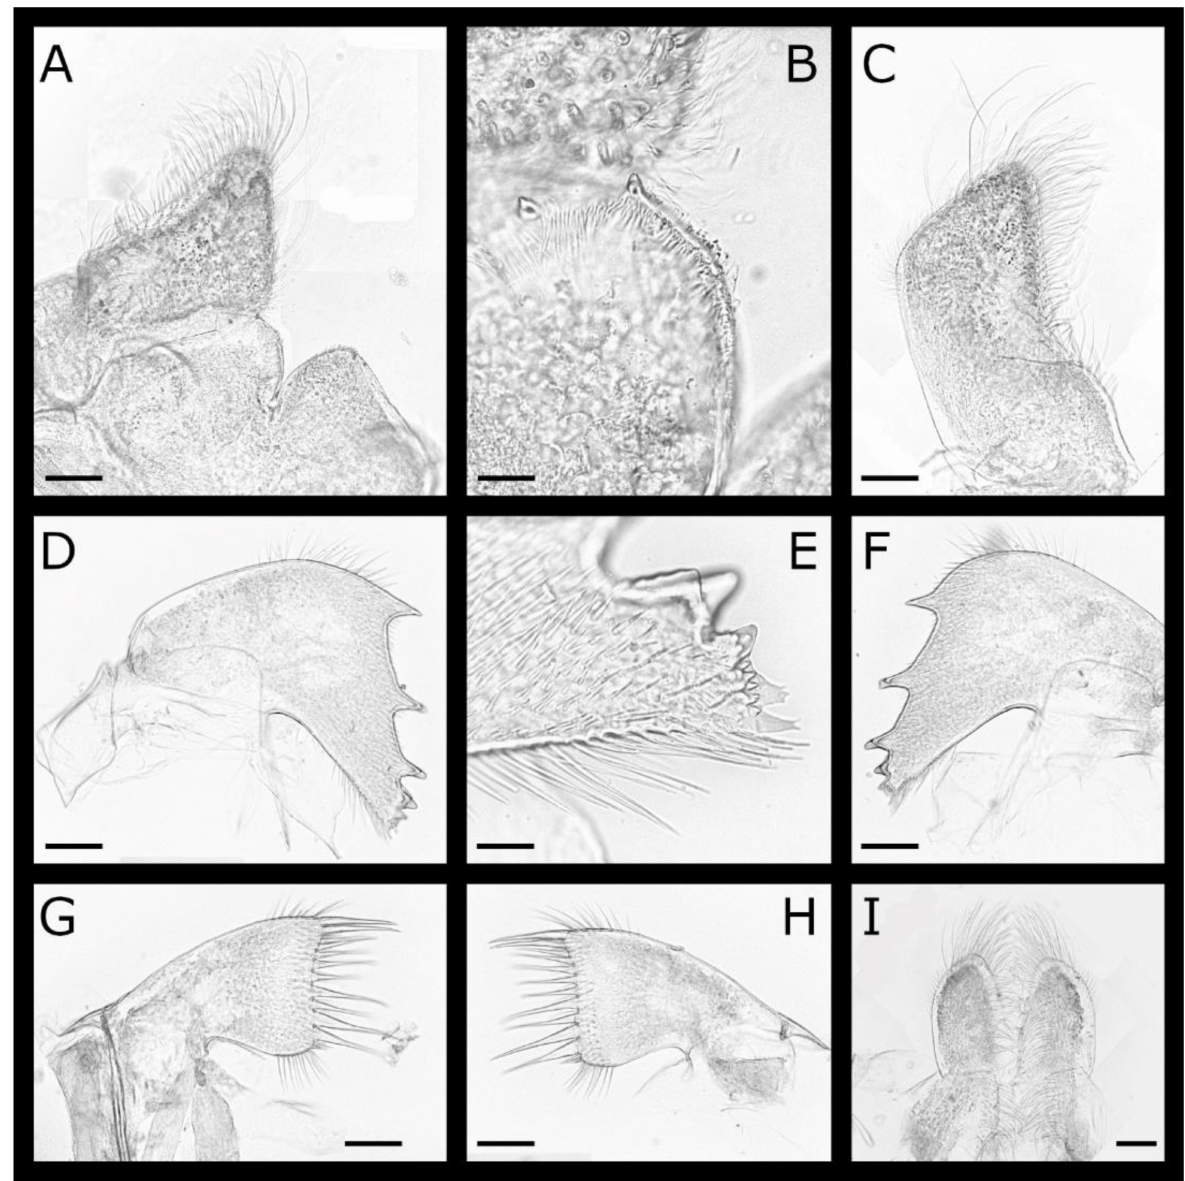
Figure 22. Pectinoacasta pectinipes (Pilsbry, 1916) mouthparts (WAM C58871) ( A ) labrum and right mandible palp; ( B ) crest of labrum; ( C ) left mandible palp; ( D ) right mandible; ( E ) close up of inferior angle of right mandible; ( F ) left mandible; ( G , H ) right and left maxillules; ( I ) right and left maxillae. Scale bars: A, C,D, F–I = 100 µ m; B, E = 50 µ